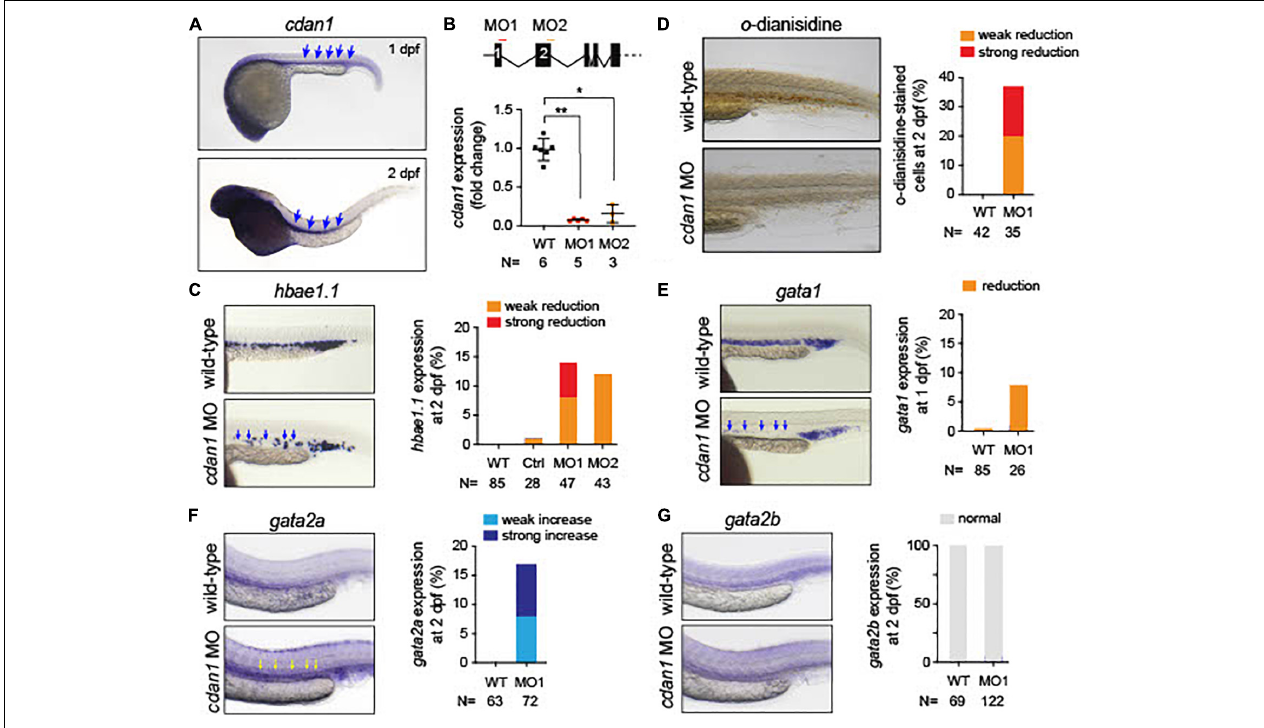
FIGURE 8 | Loss of cdan1 impairs erythropoiesis in zebrafish embryos. (A) Expression of zebrafish cdan1 at 1 dpf (top) and 2 dpf (bottom). The arrows indicate the expression of cdna1 in the embryonic hematopoietic site. (B) Top, schematic diagram of zebrafish cdan1 gene organization. The binding sites of two morpholinos (MO) are highlighted by red and orange lines. Note zebrafish cdan1 gene contains 28 exons, however, only the first 5 exons are illustrated. Bottom, relative cdan1 expression in wild type (WT) and two cdan1 morphants illustrating that the expression level of cdan1 was strongly reduced upon MO1 or MO2 injection. N indicates the number of biological replicates. (C) Expression pattern of hemoglobin alpha embryonic 1.1 . ( hbae1.1.) in WT and cdan1 morphants at 1 dpf. The left panel depicts representative images of the hematopoietic tissue. The right depicts the frequency of embryos that show phenotype. Note that injection of control (Ctrl) MO showed a minor effect on hbae1.1. expression. (D) o -dianisidine staining in WT and cdan1 morphants. The left panel depicts representative images of stained embryos 2 dpf. The right panel depicts the frequency of embryos showing phenotype. (E–G) Expression pattern of gata1 (E) , gata2a (F) , and gata2b (G) in the WT and cdan1 morphants. The left panel depicts representative images of the hematopoietic tissue. The right panel depicts the frequency of embryos that show phenotype. N indicates the number of biological